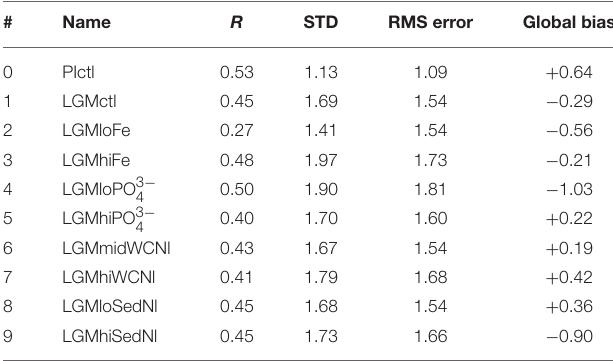
TABLE 3 | δ 15 N model-data statistical